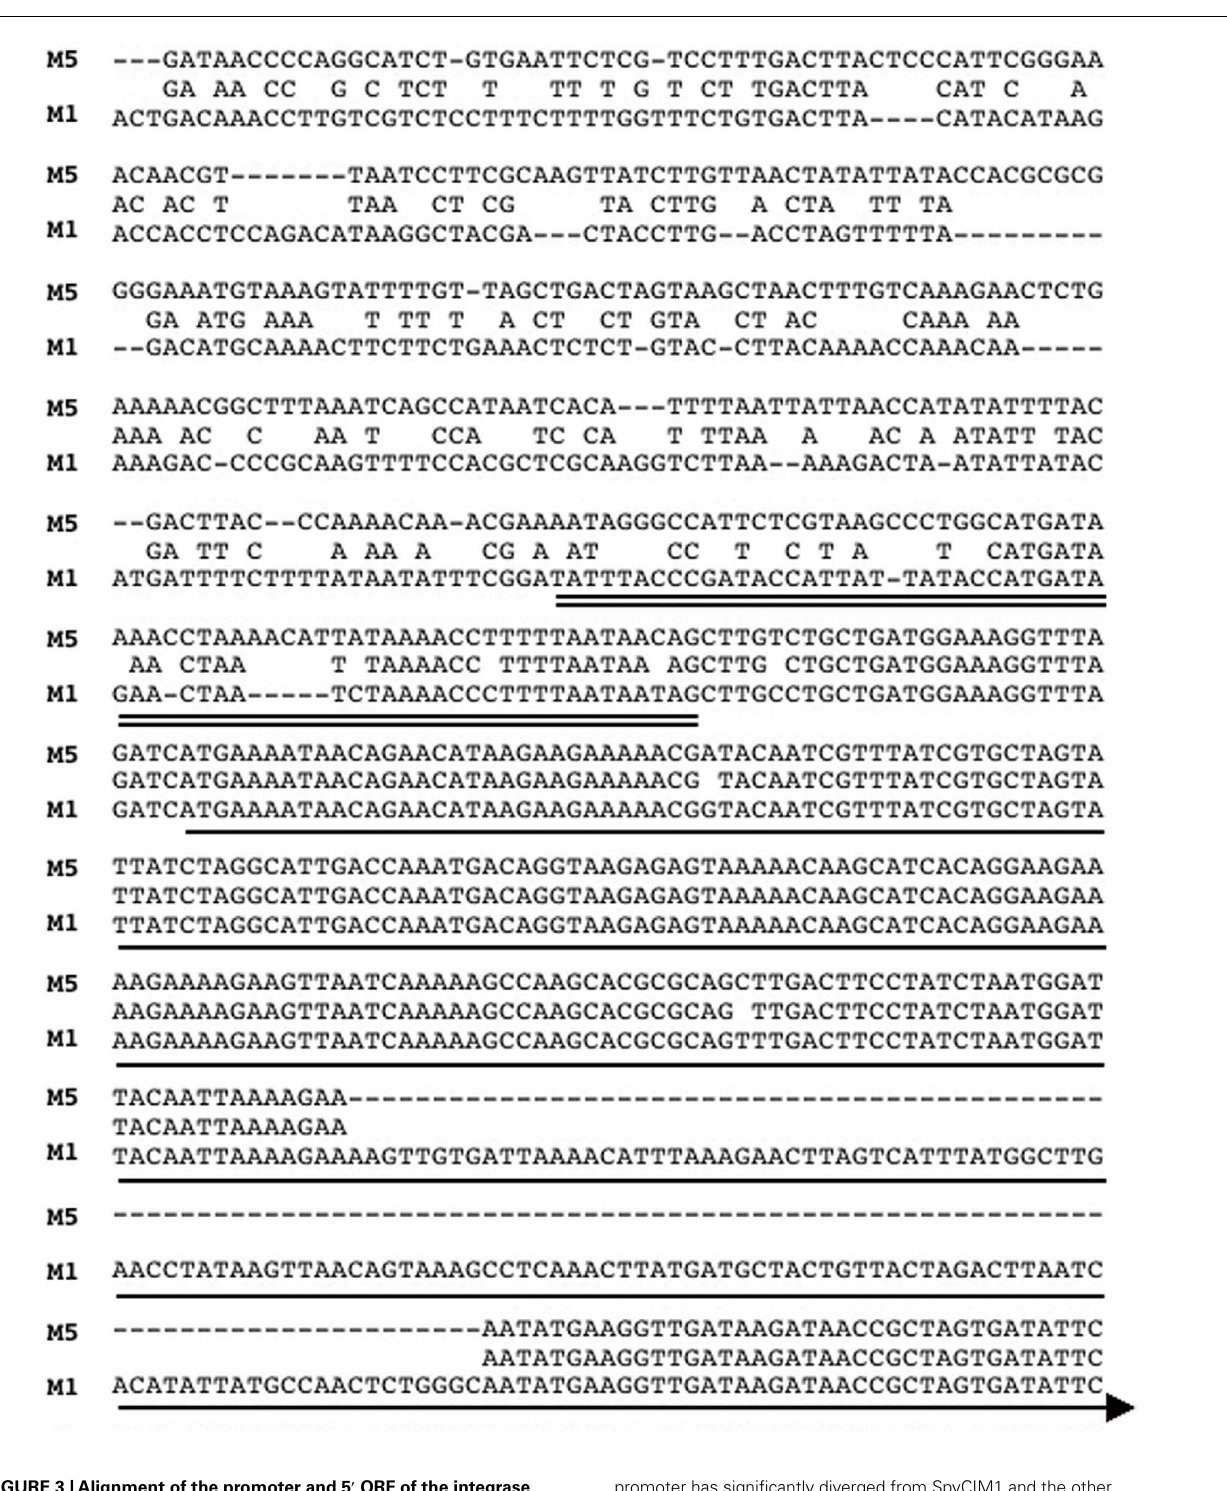
promoter has significantly diverged from SpyCIM1 and the other SpyCI-like chromosomal islands.The alignment shows that 128bp have been deleted from the SpyCIM5 int , resulting in not only a loss of genetic information but also the formation of a frameshift.Thus, computational analysis predicts that the Manfredo SpyCIM5 integrase is a non-functional